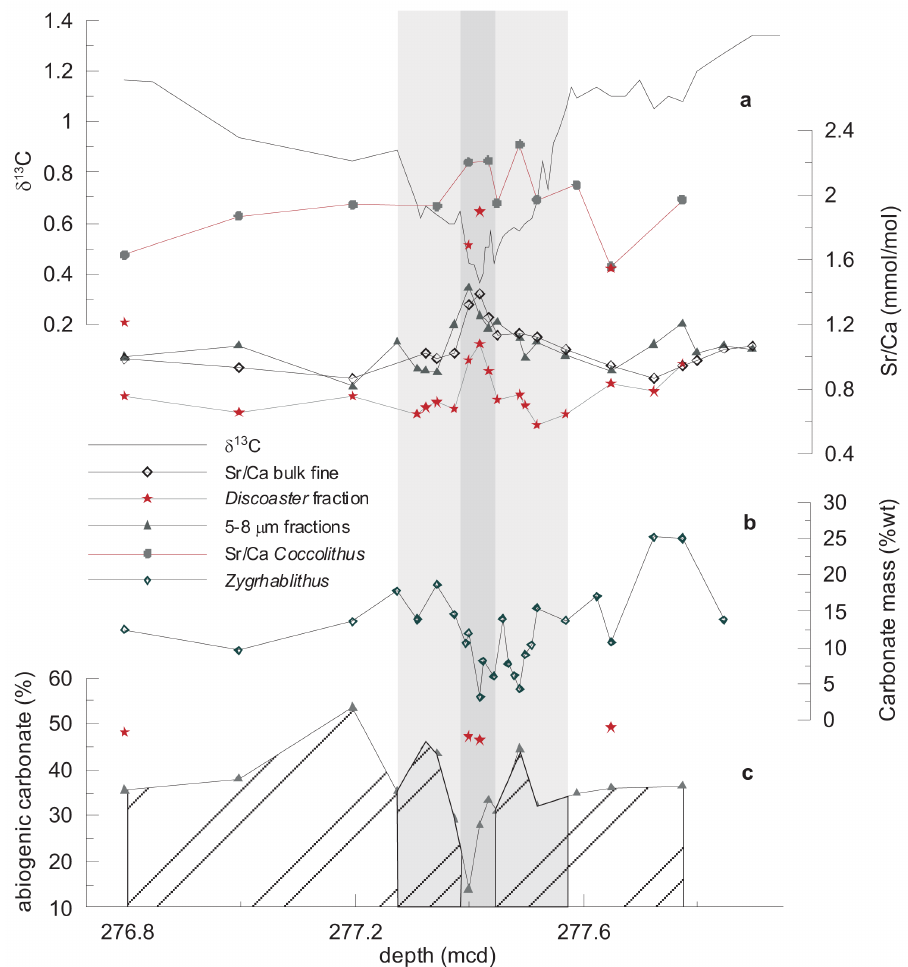
Fig. 5. (a) The Sr/Ca measured by ion probe in Coccolithus versus the Sr/Ca measured in the size fractions in correlation to the δ 13 C, (b) the mass contribution by Zygrhablithus to the 5–8µm size fractions, and (c) the contribution of abiogenic calcite to the discoaster and 5–8µm size fractions. Grey bar represents the Elmo horizon, light-grey bars the